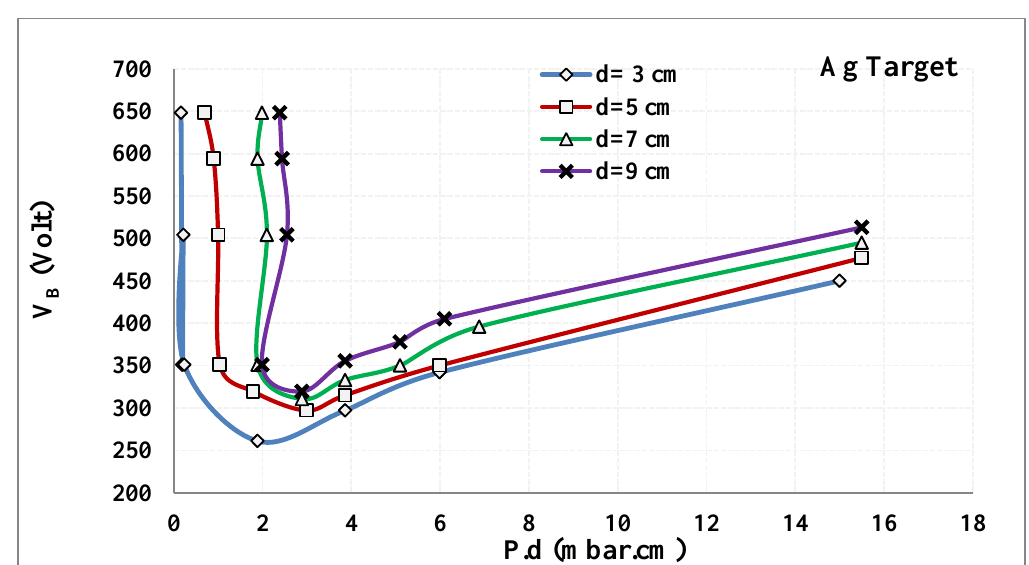
Fig. 5: Paschen curves of the glow discharge in argon for the Ag cathodes for different inter-electrode